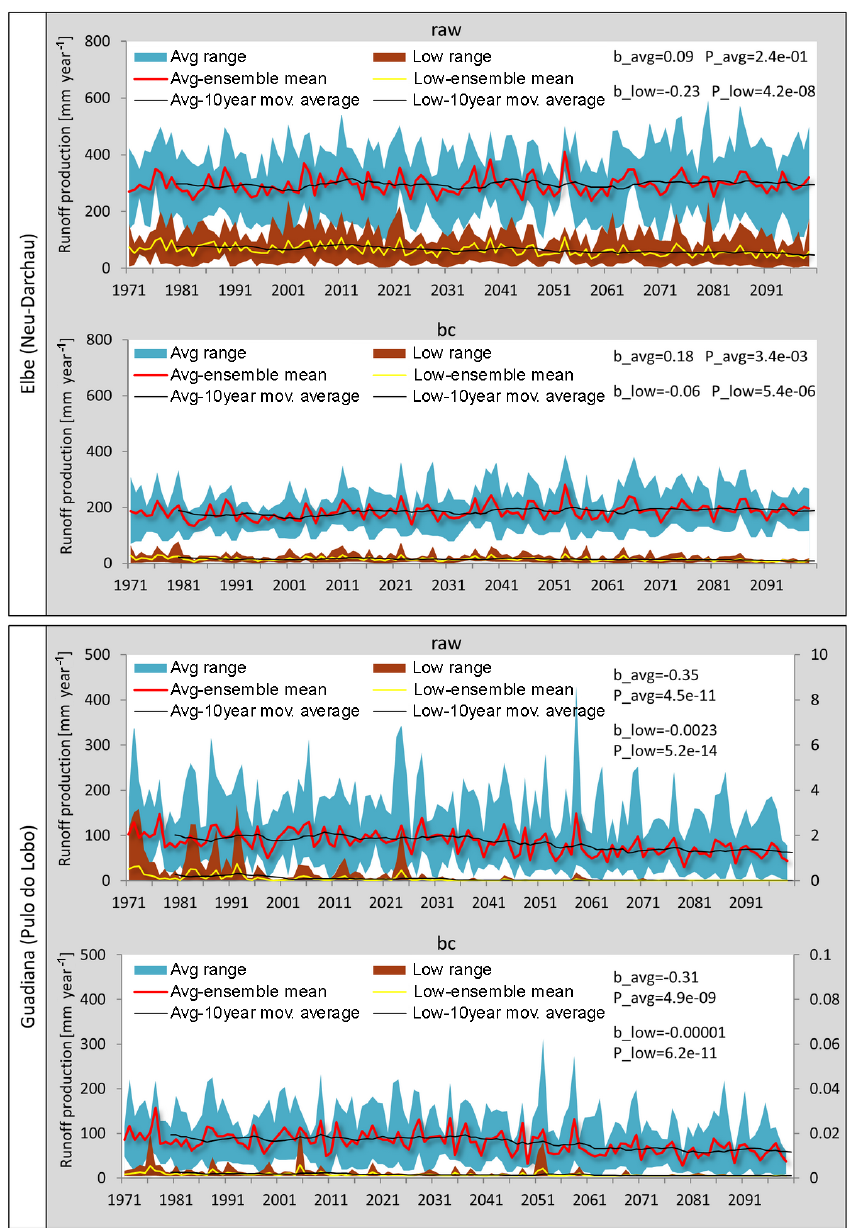
sult in an improvement in GCM agreement, probably due to its very low values of 10th percentile runoff. Kemijoki is not included in the 10th percentile scatterplots as its projected increase far exceeds the 100 % limit selected. For the rest of the basins, the effect of the bias correction on the change of the 10th percentile runoff is not constant. For the Guadiana and Elbe bias adjustment mostly increases percent change, while for the Rhine and Danube percent change is in general terms decreased after bias correction.